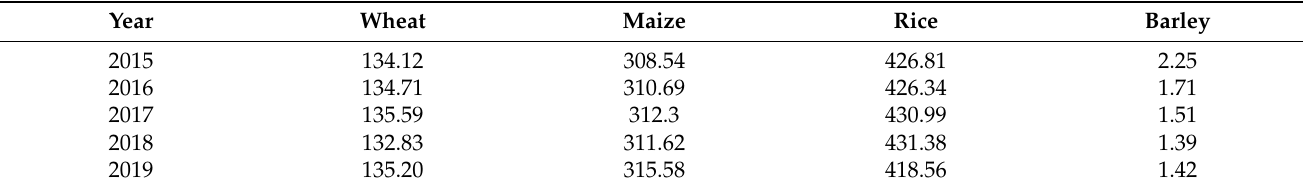
Table 1. Cereal production in East and Southeast Asia (million tonnes). Wheat Maize Rice